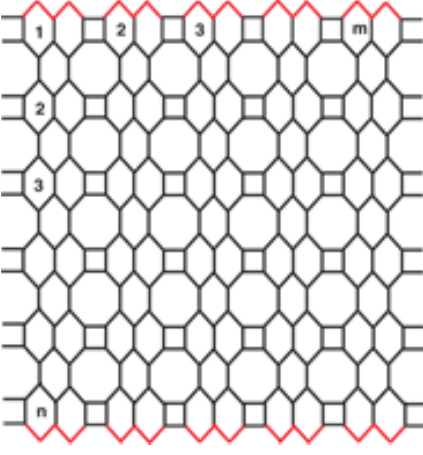
Figure 4. Naphthylenic